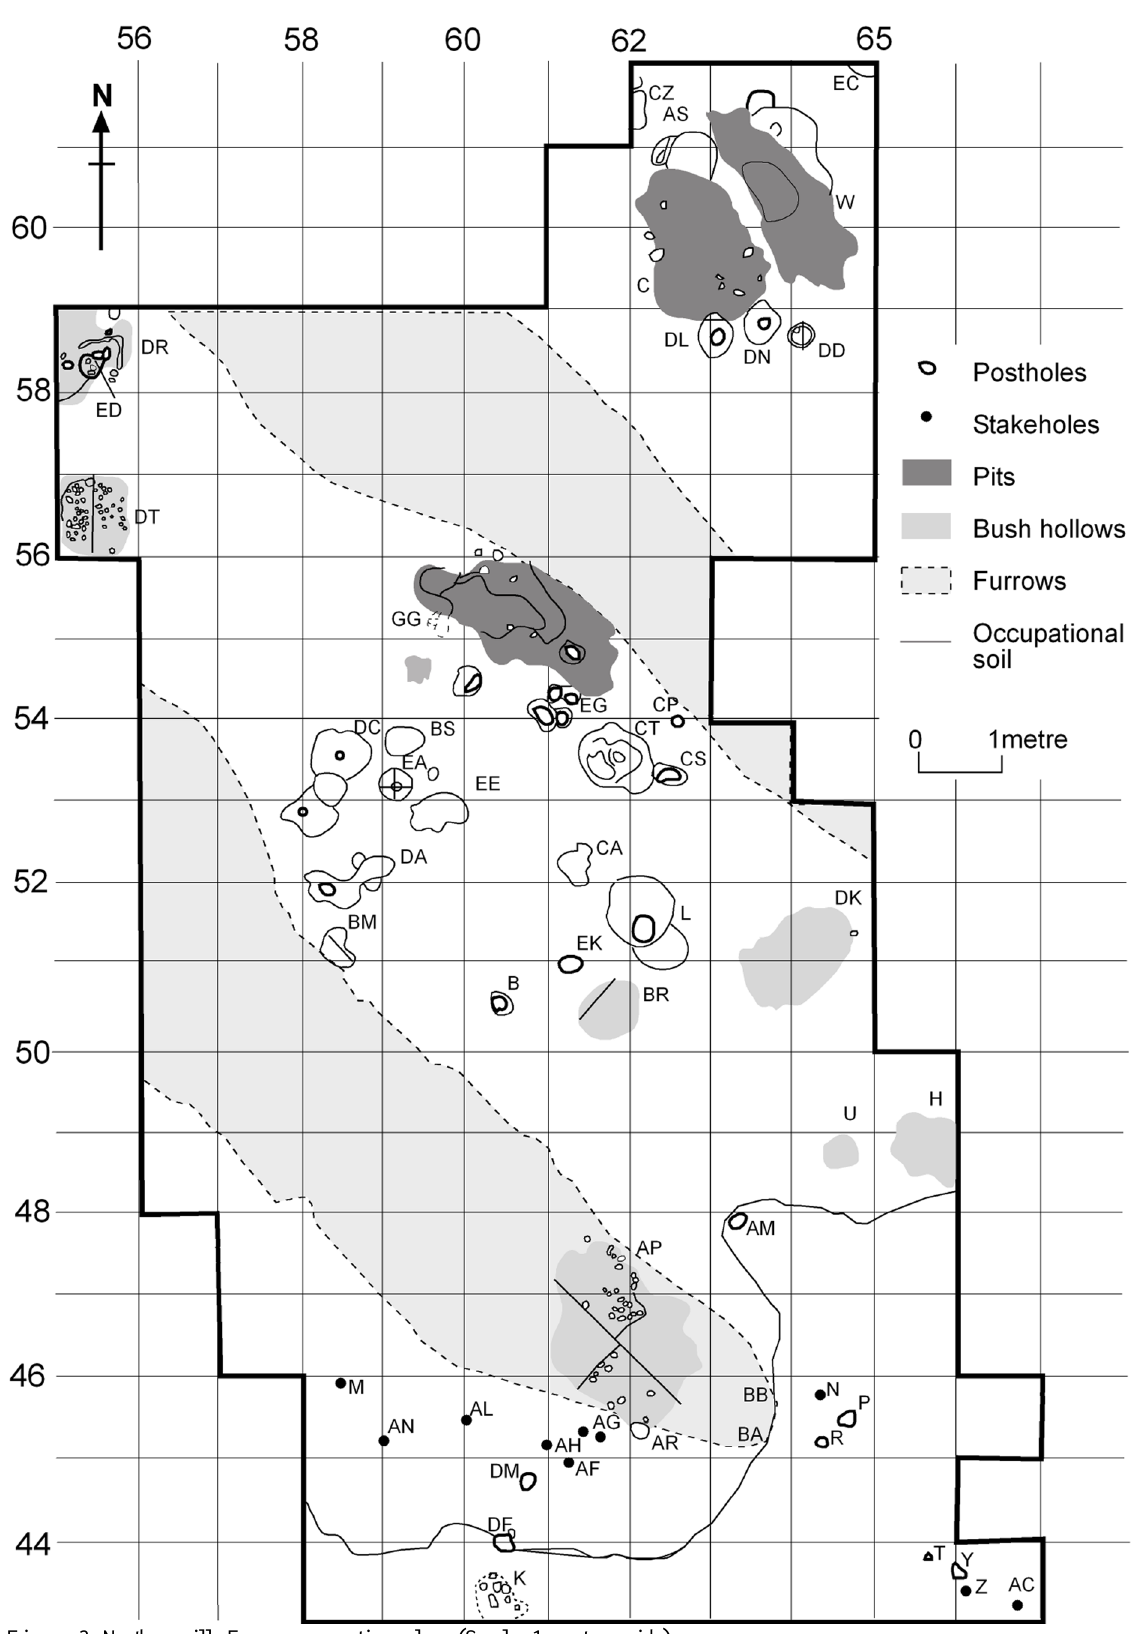
Figure 3. Nethermills Farm excavation plan. (Scale: 1 metre